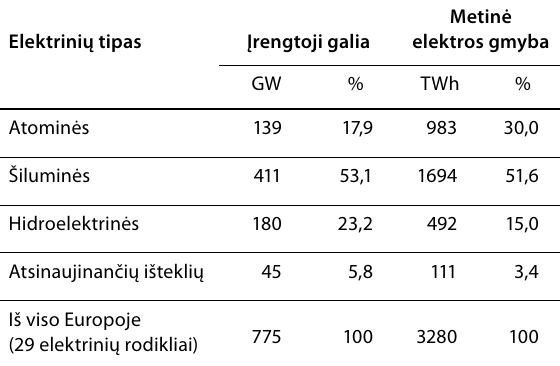
(pagal Wec studiją 2007 m.) Table 1. europe – rates of the 29 electric powerstations. 2004. (Wec study, 2007)